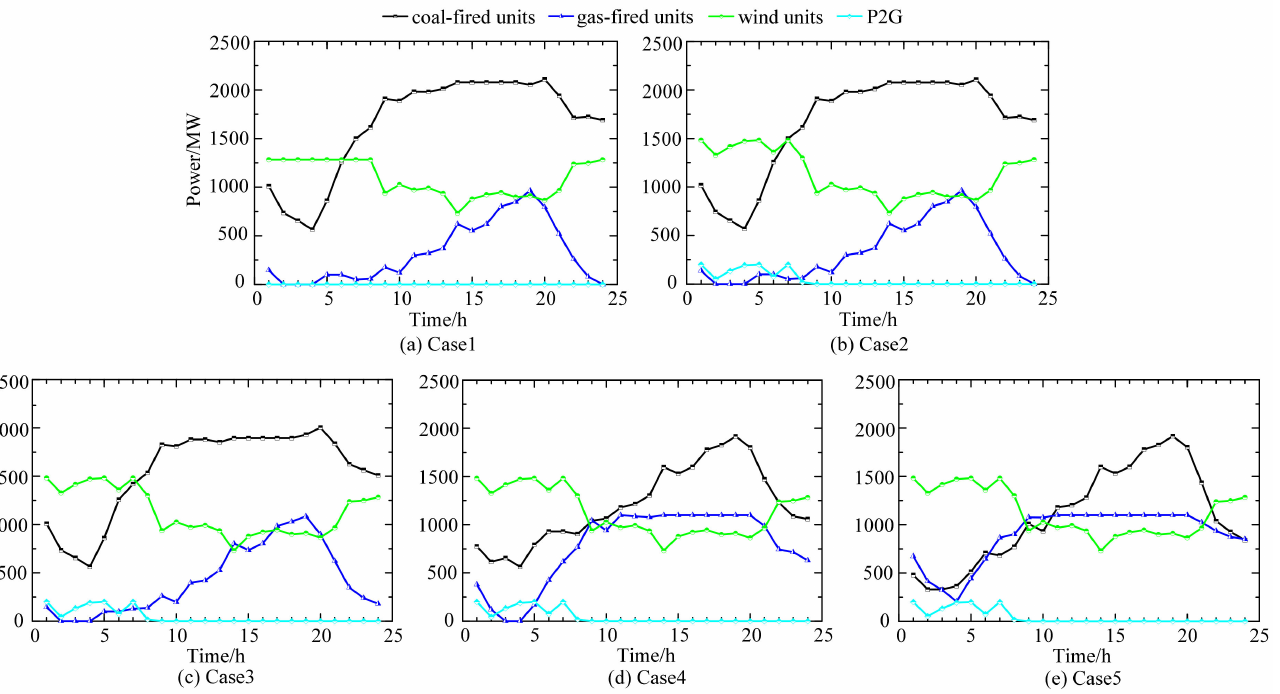
Figure 10. Power output of units in each